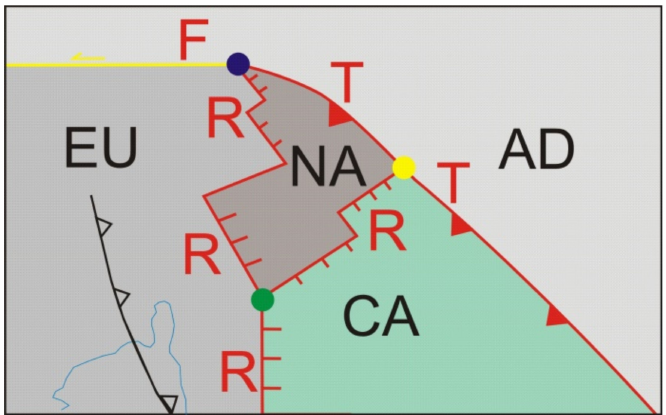
Figure 10. Scheme showing TTR-like (Trench-Trench-Ridge) and FTR-like (Fault-Trench-Ridge) triple junctions of the Apennine and RRR-like (Ridge-Ridge-Ridge) triple junction of the Tyrrhenian side. AD: Adria, CA: Central Apennine, EU: Europe, NA: North Apennine, T = Trench, R = Ridge, F: Fault; ( yellow dot ) is the TTR-like triple junction; ( green dot ) is the RRR-like triple junction, ( blue dot ) is the FTR triple